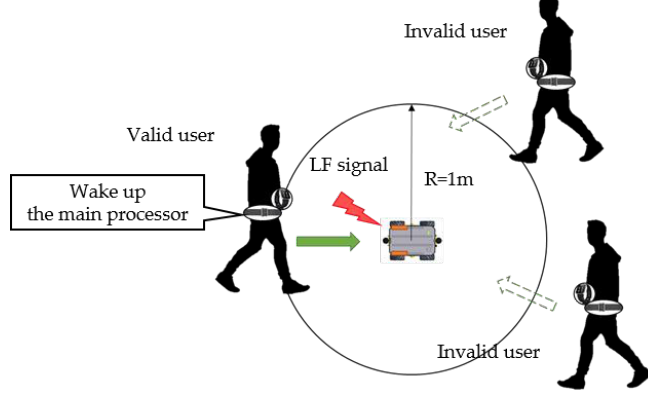
Figure 5. Master recognition.